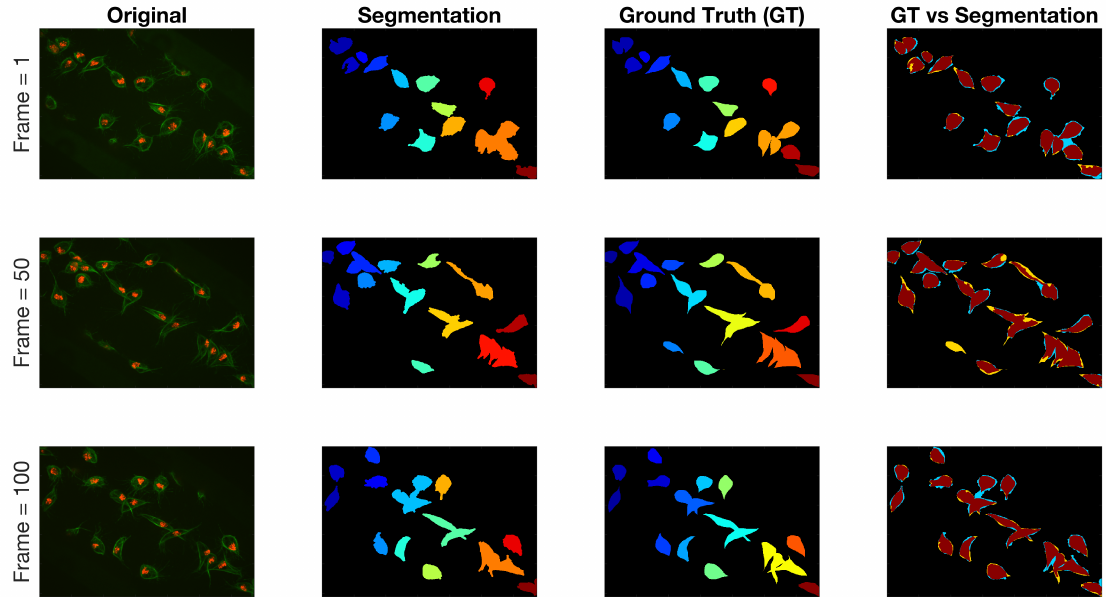
Figure 12. Qualitative comparison of segmentation technique against the ground truth on three different time frames in the dataset. The columns from left to right present the original image, the manual segmentation (GT), the result of the segmentation described in Section 2.4 and finally the comparison between both binary images. Regarding the colours in the final column: black is the background, yellow represent the false negatives, blue the false positives and red the true